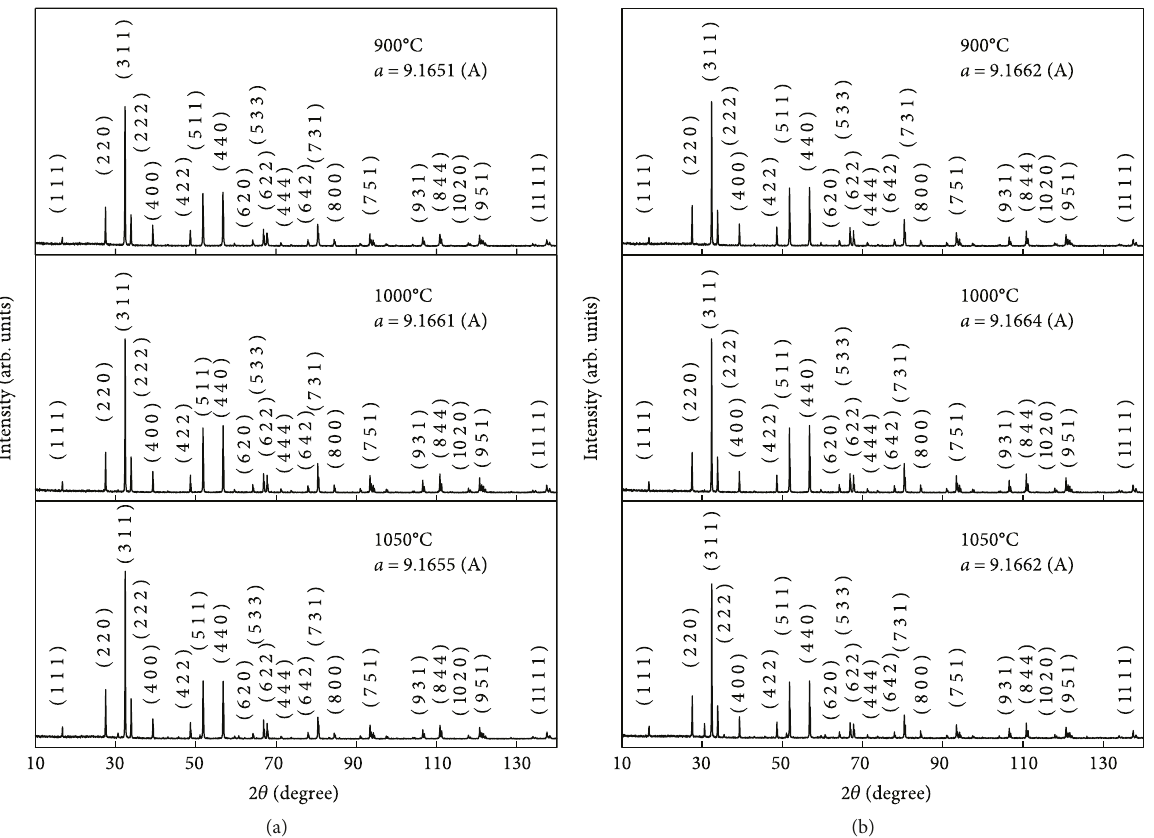
Figure 1: X-ray di ff raction patterns of CdIn